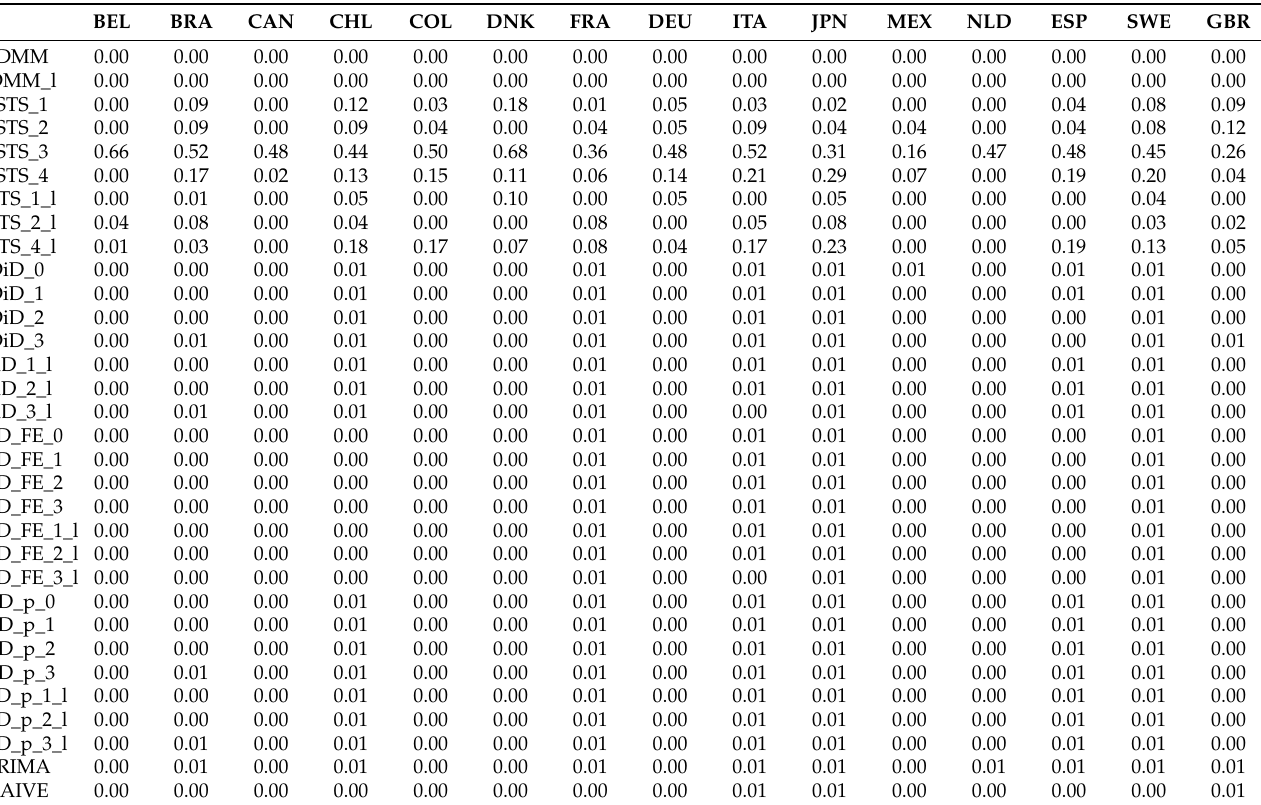
Table 5. Average p -values of the DM test over the